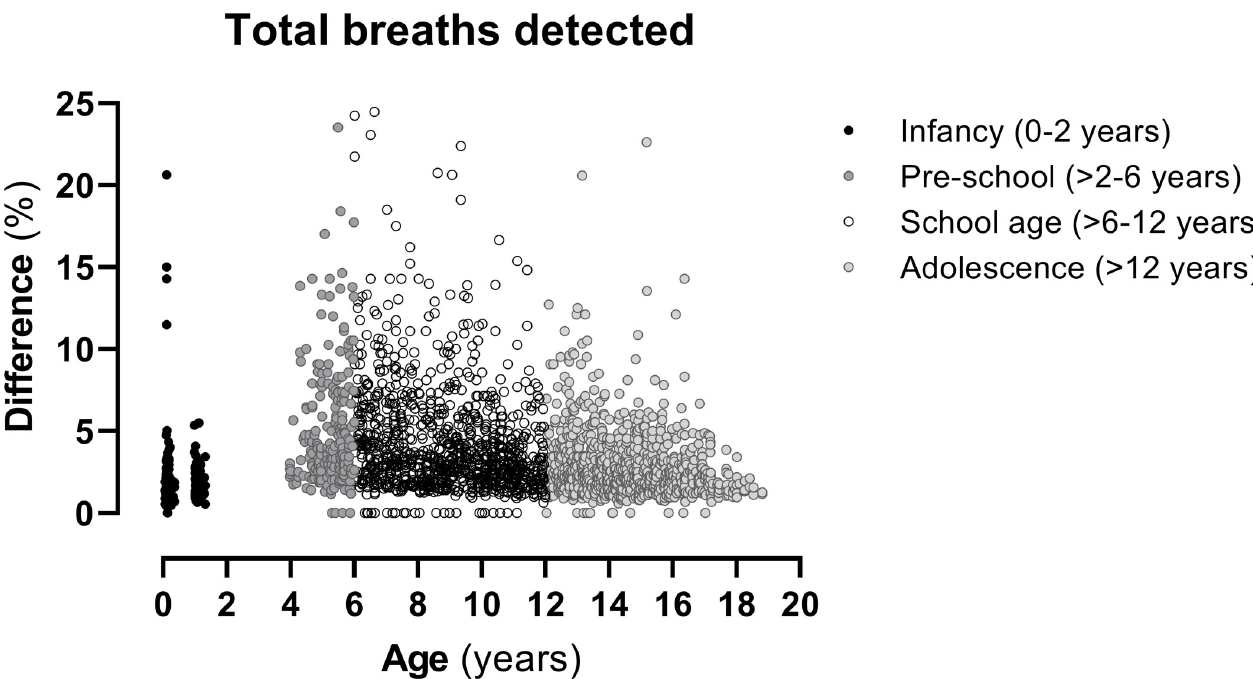
Fig 2. Relative difference [%] in total breaths detected. Comparison of the Spiroware and custom breath-dection algorithms by age group.